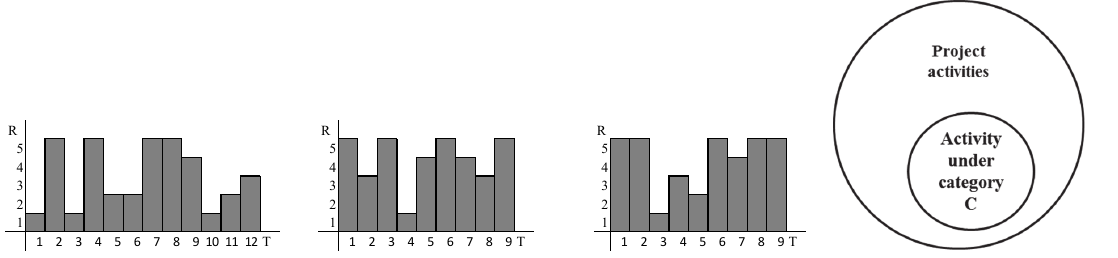
Fig. 4 . An example of activity classified under category